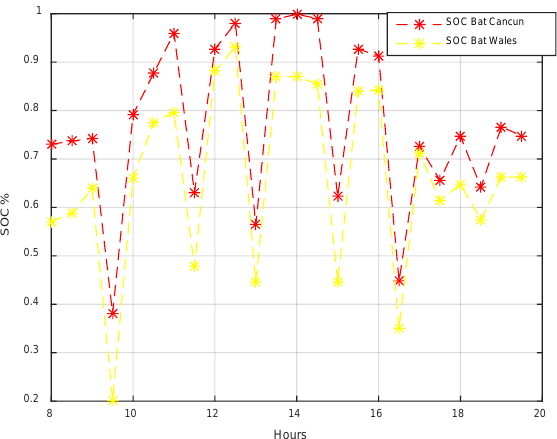
Figure 7. Result of the state of charge (SOC).